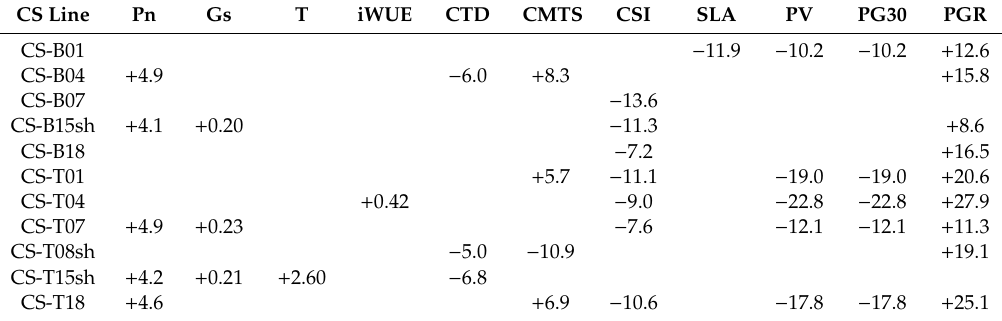
Table 2. Percent absolute di ff erence in trait means between selected CS lines and TM-01 where a significant di ff erence was detected based on Dunnett’s test ( p < 0.05) for leaf photosynthesis (Pn), leaf stomatal conductance (Gs), leaf transpiration (T), the ratio of Pn to T (iWUE), the cell membrane stability index (CMTS), the chlorophyll stability index (CSI), canopy temperature depression (CTD), specific leaf area (SLA), pollen viability (PV), pollen germination at 30 ◦ C (PG30), and the pollen germination response (PGR) measured during mid-fruiting.